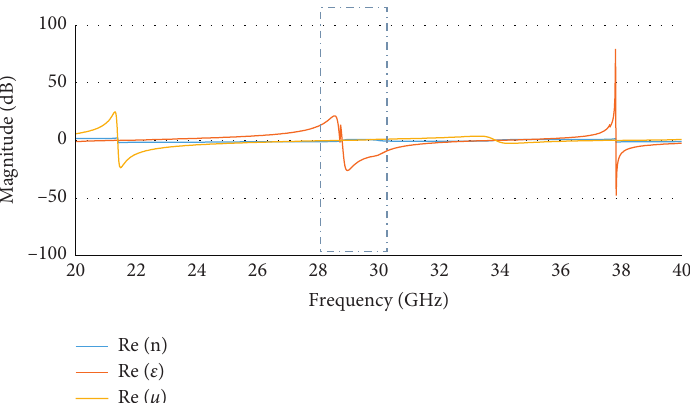
Figure 6: Metamaterial characterisation of the proposed SRR.